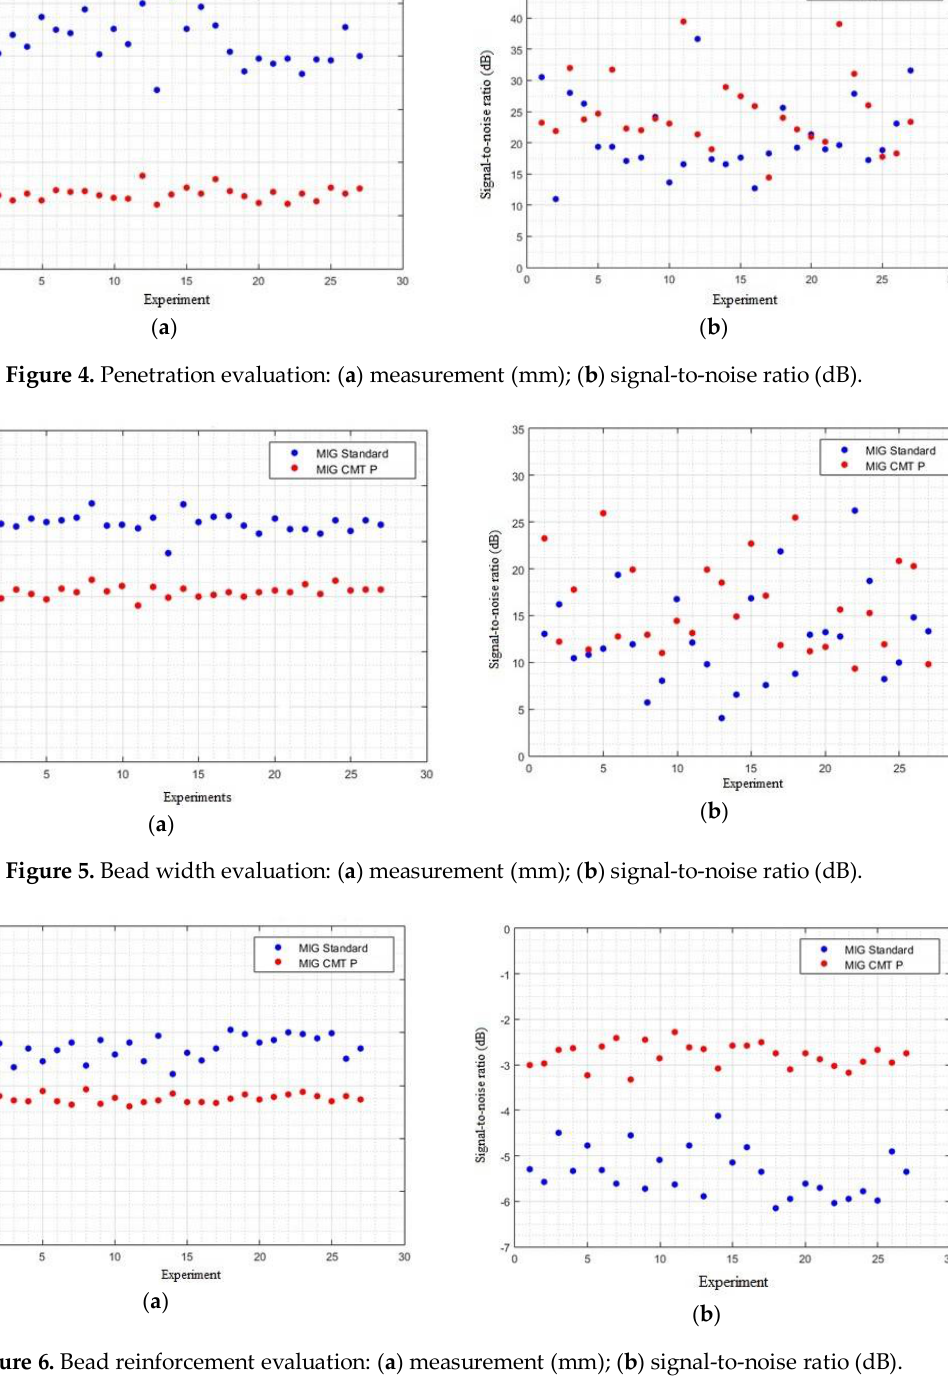
Figure 6. Bead reinforcement evaluation: ( a ) measurement (mm); ( b ) signal-to-noise ratio